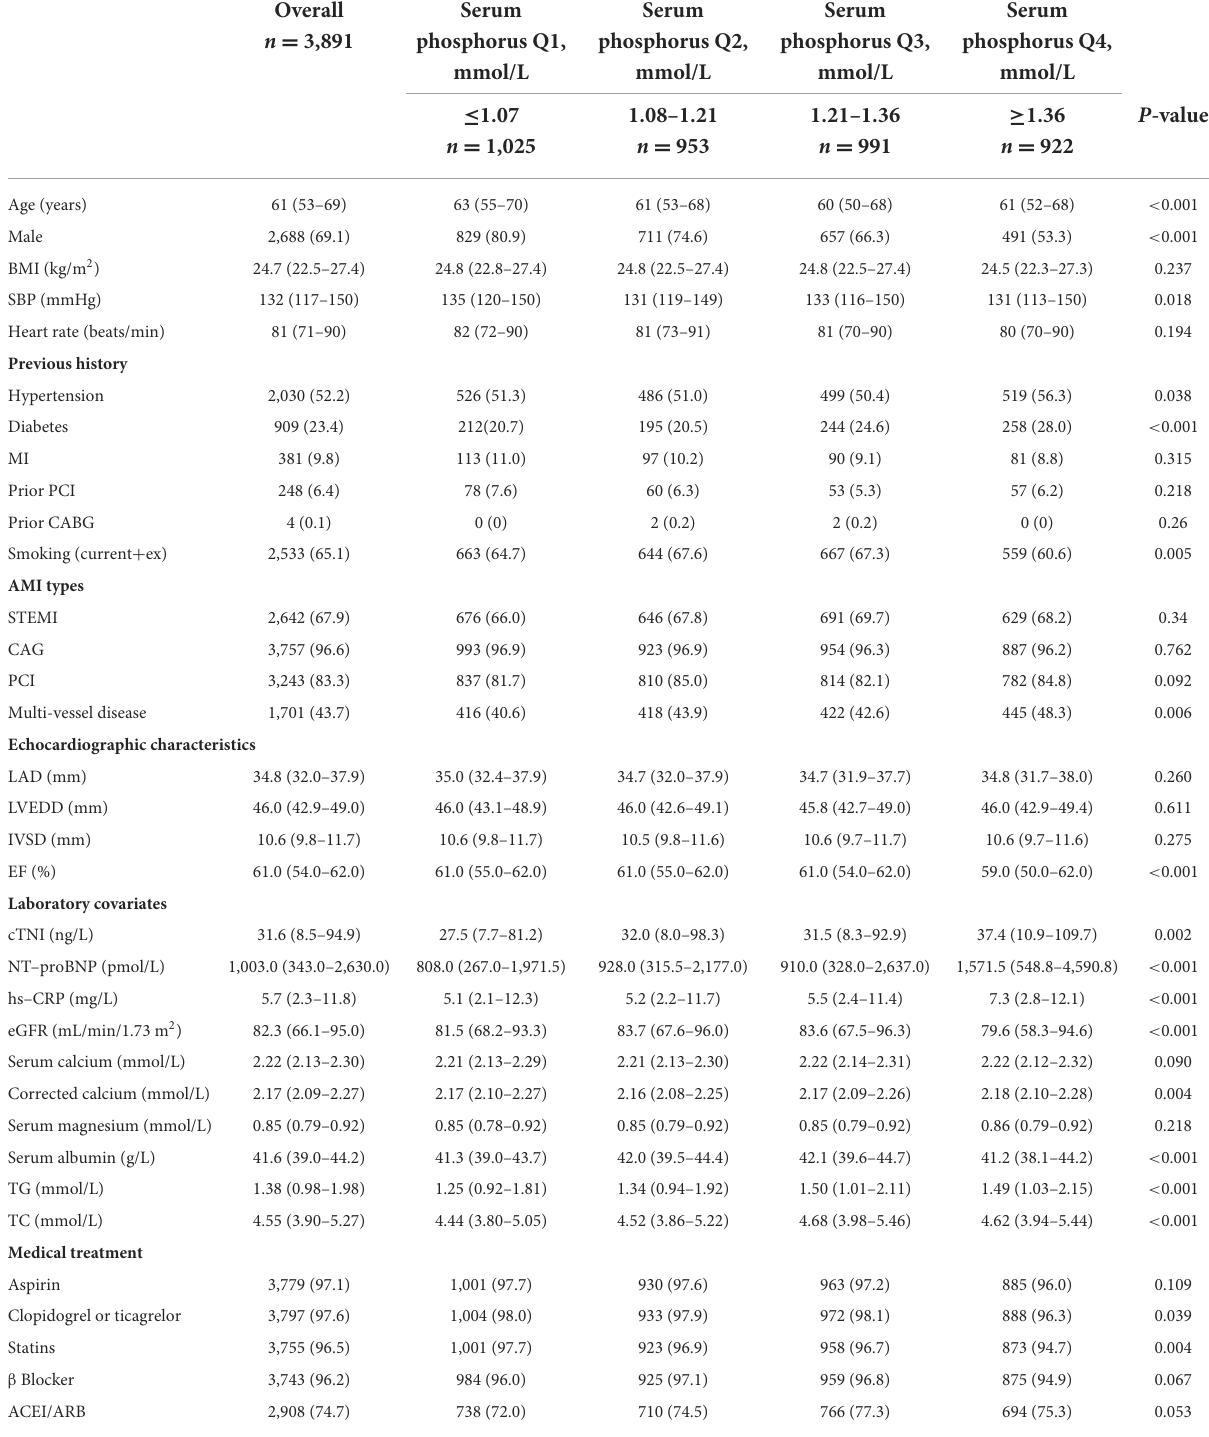
TABLE 1 Participant characteristics by quartiles of serum phosphorus at